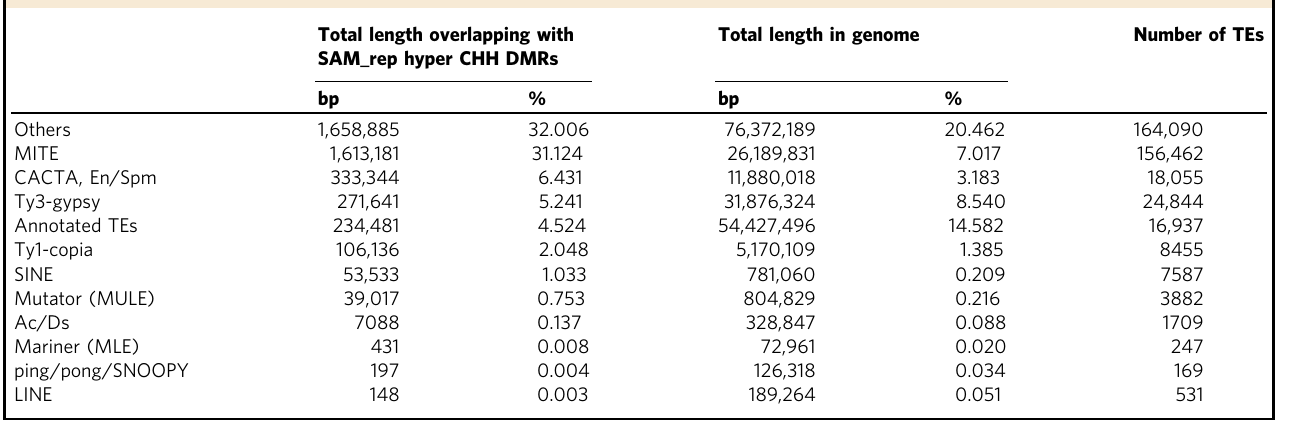
Table 1 Transposable elements overlapping with